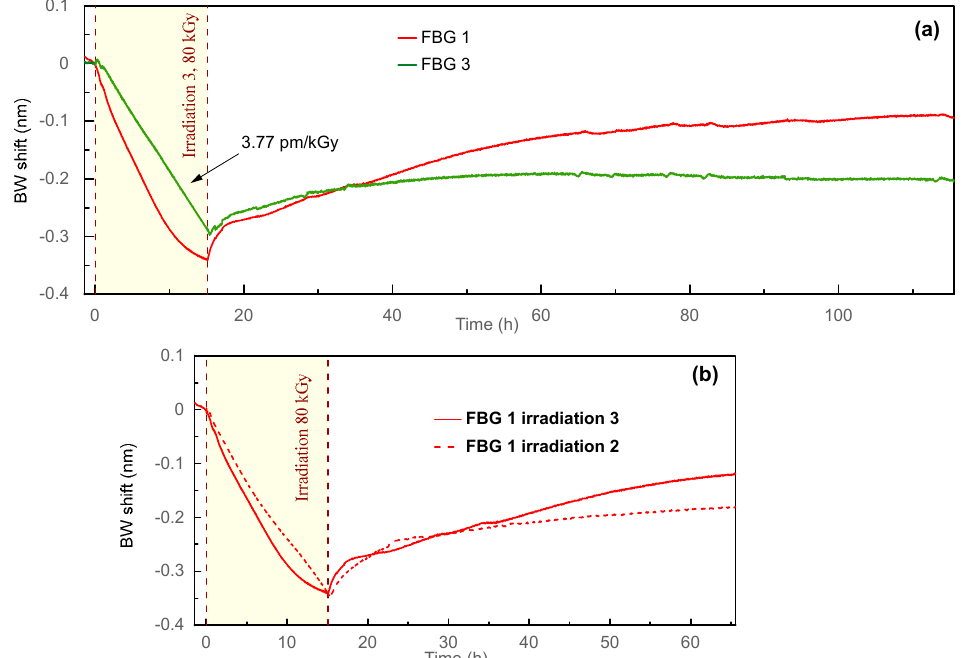
Figure 5. ( a ) The BW evolution during the third irradiation session (80 kGy); ( b ) comparison of irradiation sessions 2 and 3 (both 80 kGy) of FBG 1 (time offset was applied to the graph of irradiation 2 presented in Figure 4 to make it start at 0 h).